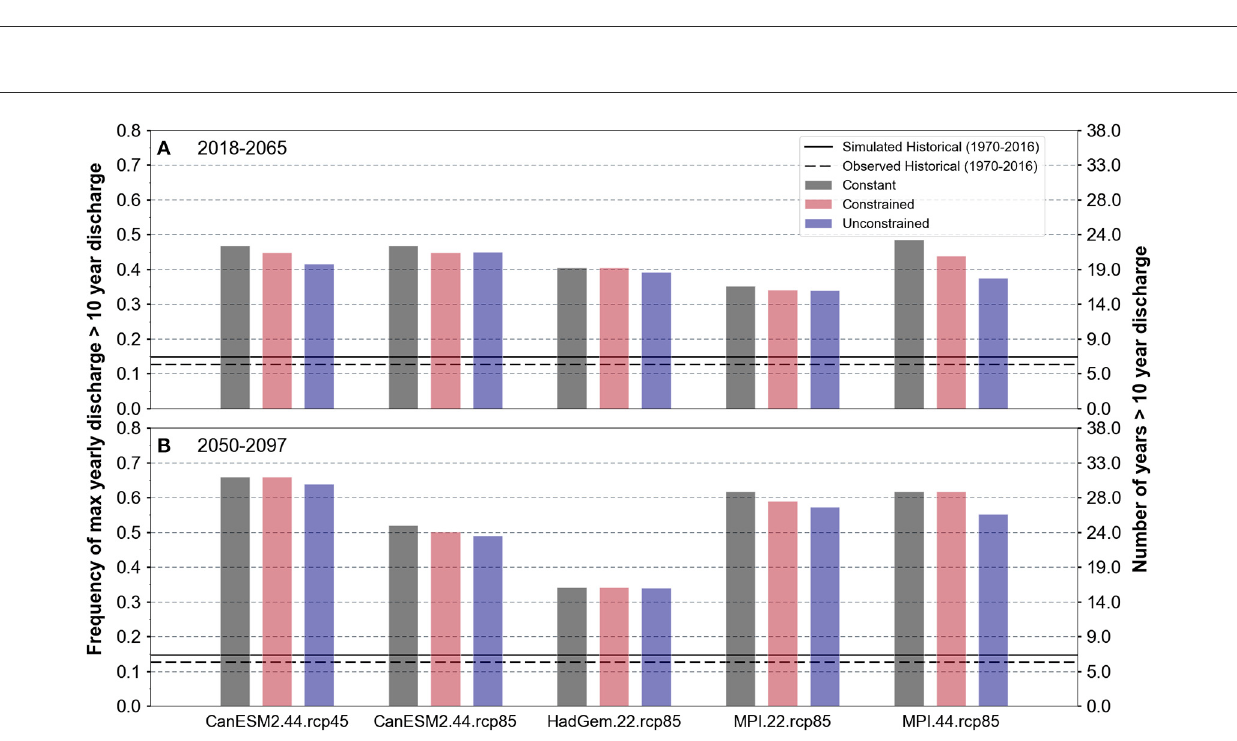
FIGURE8 Percent of total impact on the 95th percentile discharge from the human system (black) and the climate system (red). (A, C, E, G, I) depict 2018–2065 and (B, D, F, H, J) depict 2050–2097.